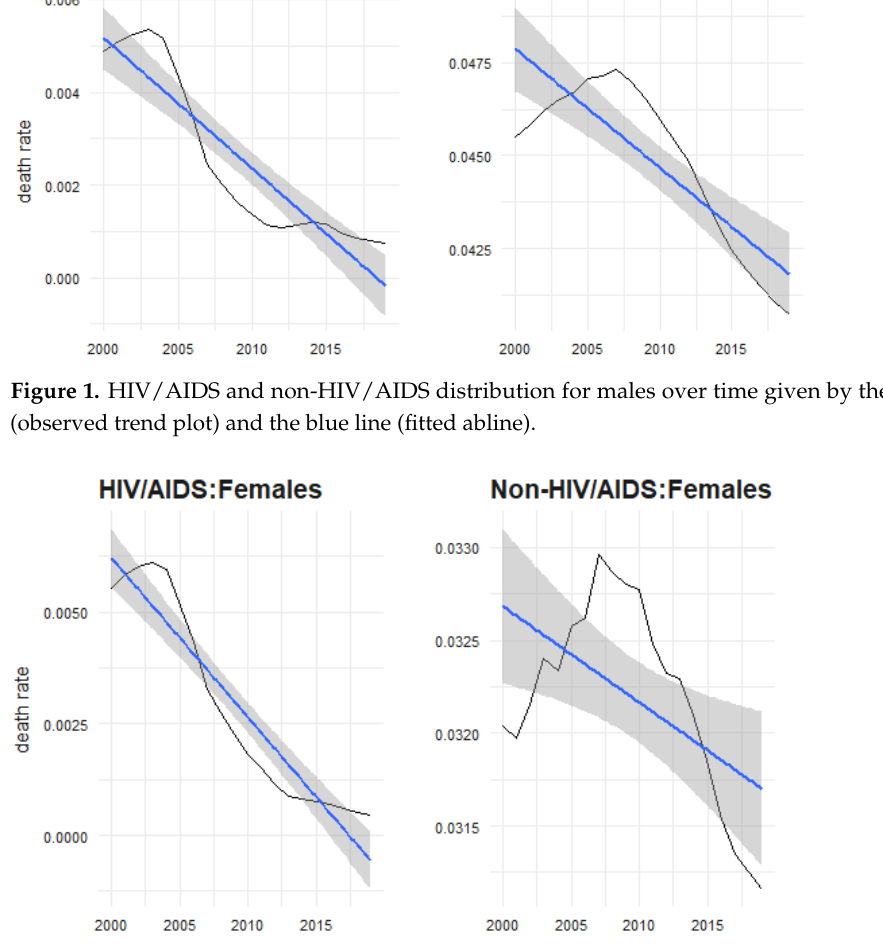
Figure 2. HIV/AIDS and non-HIV/AIDS distribution for females over time given by the black line (observed trend plot) and the blue line (fitted abline)..